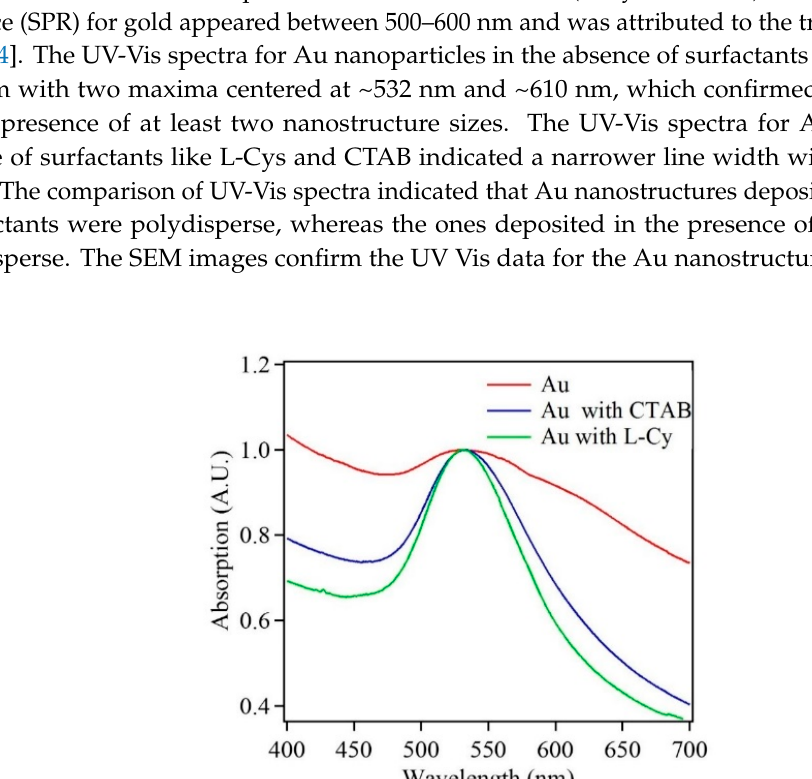
Figure 9. RMS roughness of Au samples after one (1X), three (3X), and five (5X) deposition cycles. confidence intervals. Mean values from five different locations on each sample are shown. Error bars represent 95% confidence intervals.